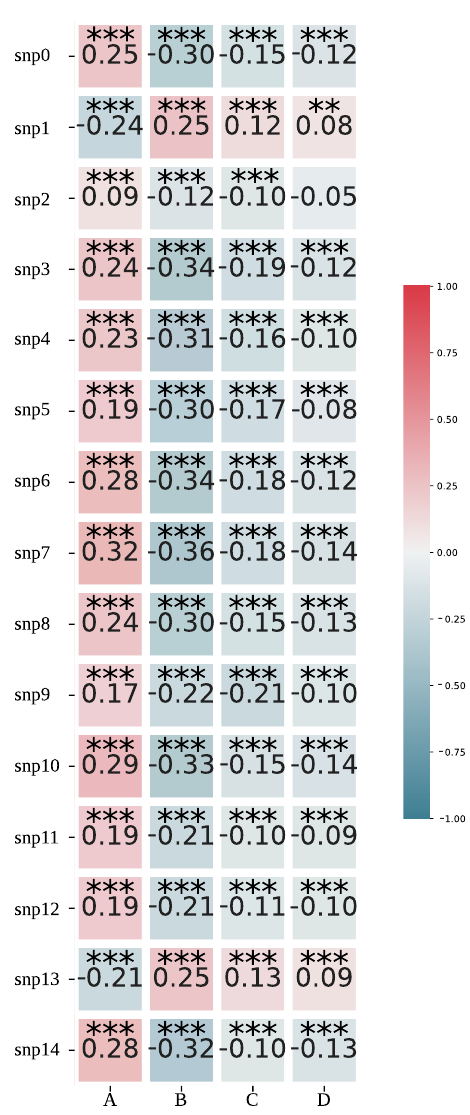
Figure 9. Pearson correlation coefficient between SNP value and the change in time to flowering ( A ); maximum slope ( B ); maximum rate of change of the slope ( C ); standard deviation of time to flower- ing ( D ). The significance is marked with asterisk; 0.001 ≥ p _value < 0.01: **; p _value < 0.001: